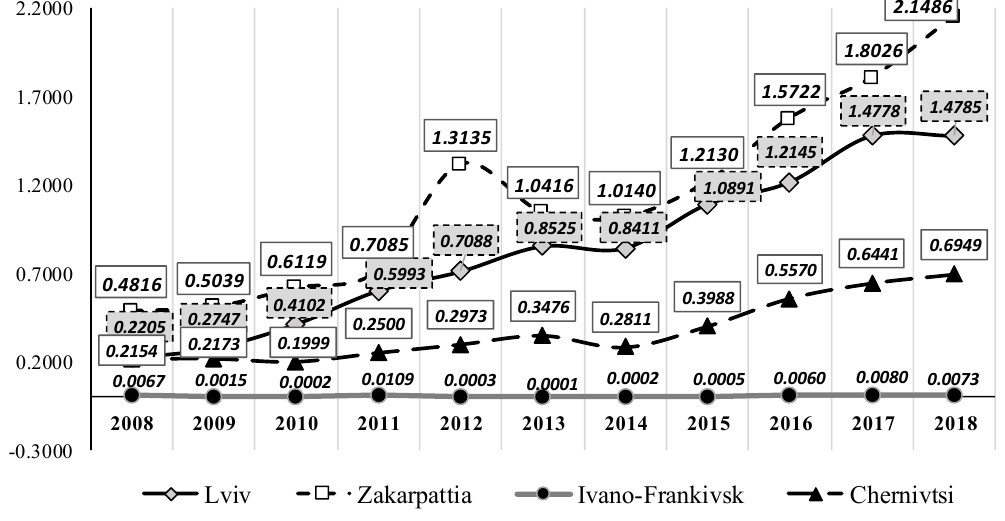
Figure 1. External population migration intensity by regions in the Carpathian Region,